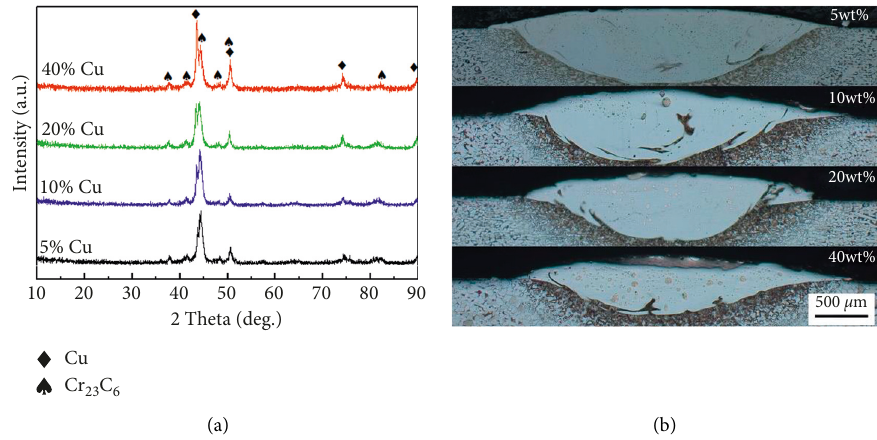
Figure 2: (a) The XRD patterns and (b) the cross-sectional OM images of the coatings with different copper addition percentages (5wt%, 10wt%, 20wt%, and